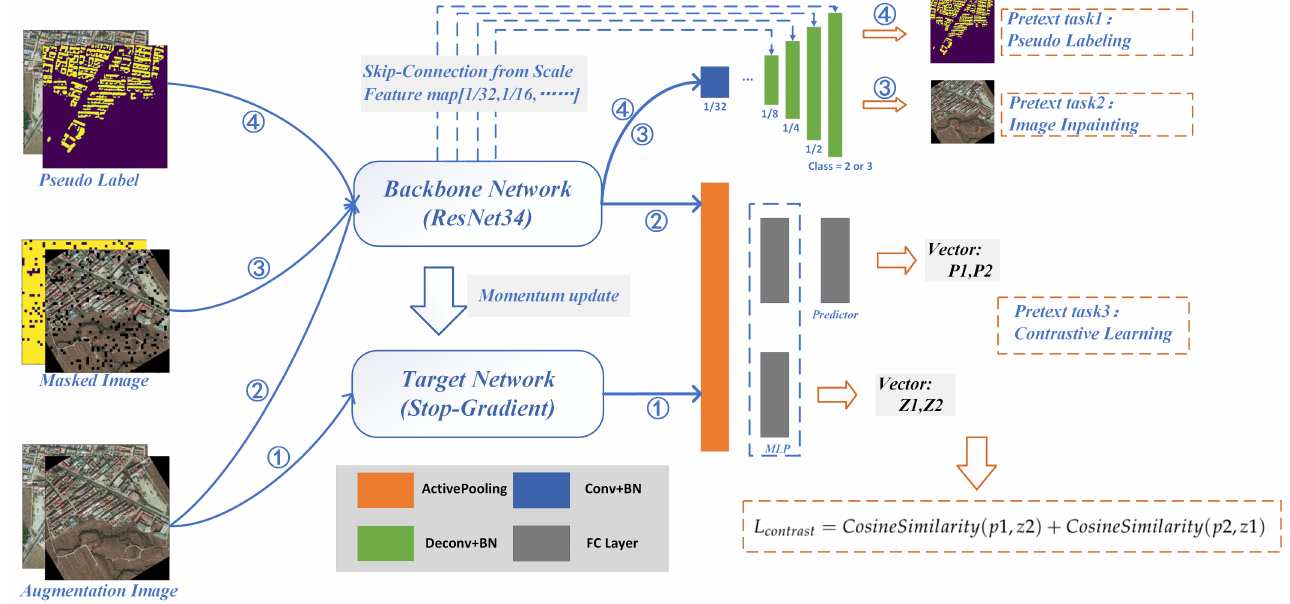
Figure 1. Overview of the proposed pseudo-label-guided self-supervised learning